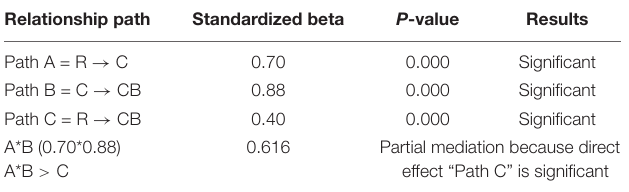
TABLE 5 | Mediation analyses with